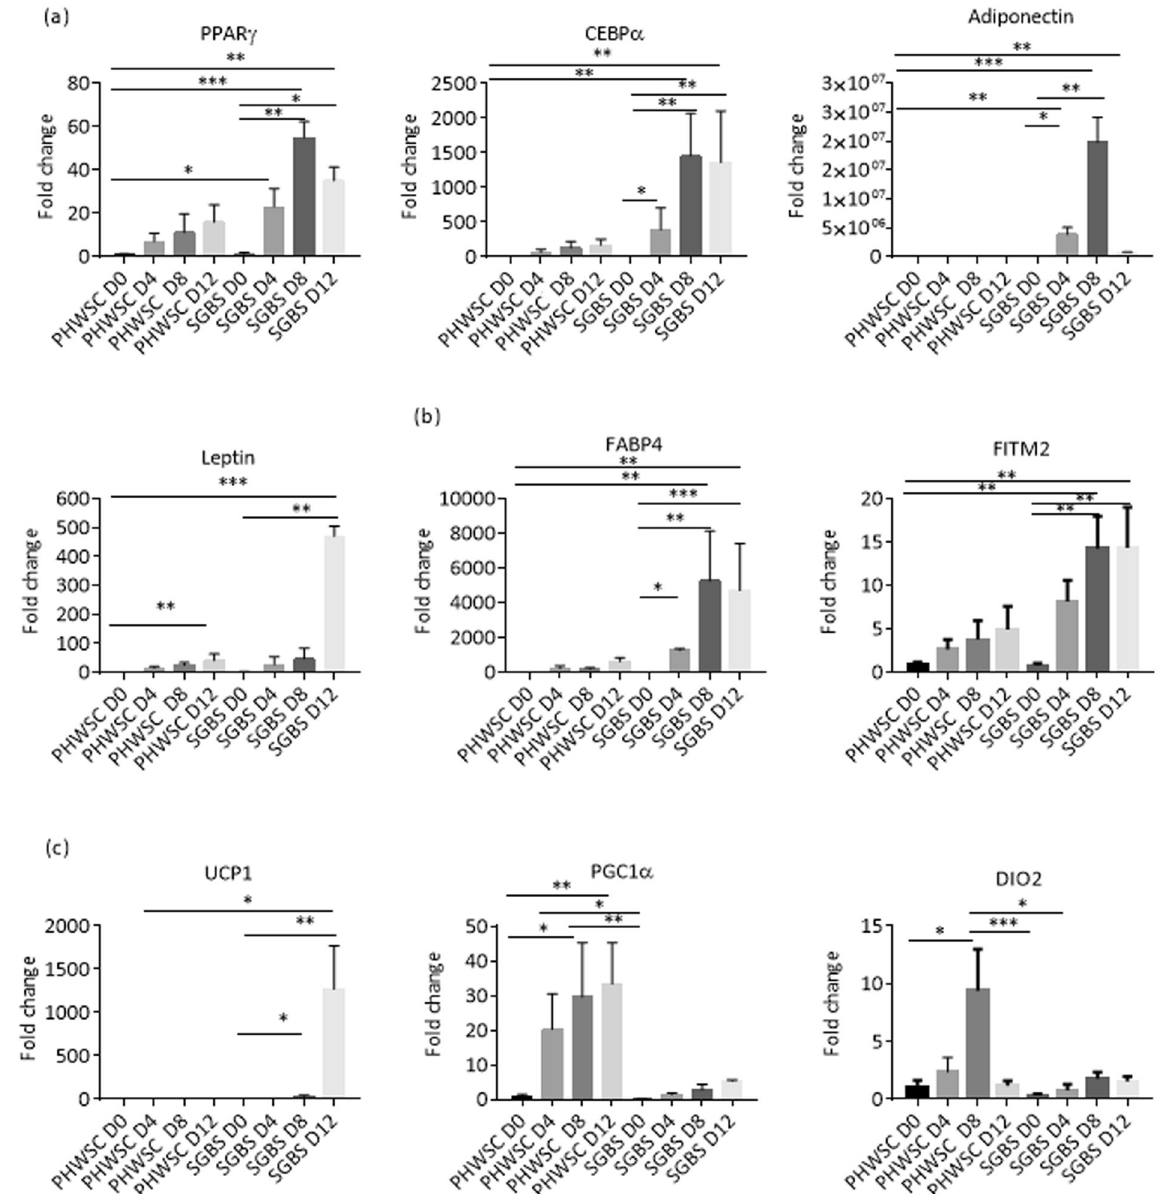
Figure 2. Expression profiling of differentiating SGBS and PHWSC adipocytes, for genes involved in ( a ) adipogenesis ( b ) lipid storage ( c ) browning. Days of differentiation are indicated as D0, D4, D8, D12 respectively. For experiments involving PHWSC adipocytes, experiments were performed in duplicates from cells derived from 3 different donors. For SGBS adipocytes, experiments were performed in duplicates for 3 independent experiments from the same SGBS adipocyte. Data represented as mean ± SD and was normalized to SC control D0 samples. Two-way ANOVA was used to test for statistical significance. * P < 0.05, ** P < 0.01, *** P < 0.001, **** P <